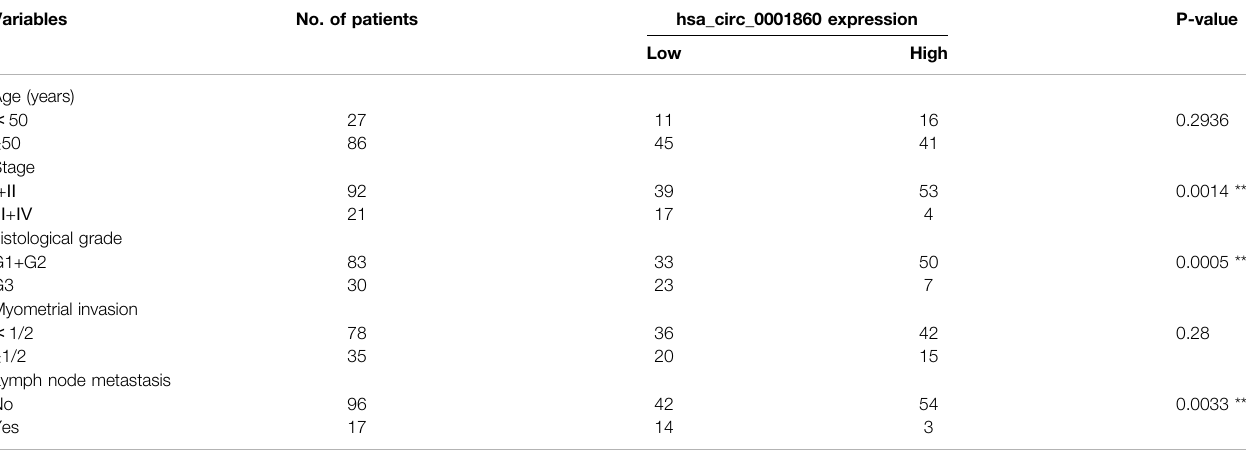
TABLE 1 | Correlation of relative hsa_circ_0001860 expression with the clinicopathological characteristics of 113 patients with endometrial cancer. Note. * p < 0.05, ** p < 0.01, *** p < 0.001. Variables